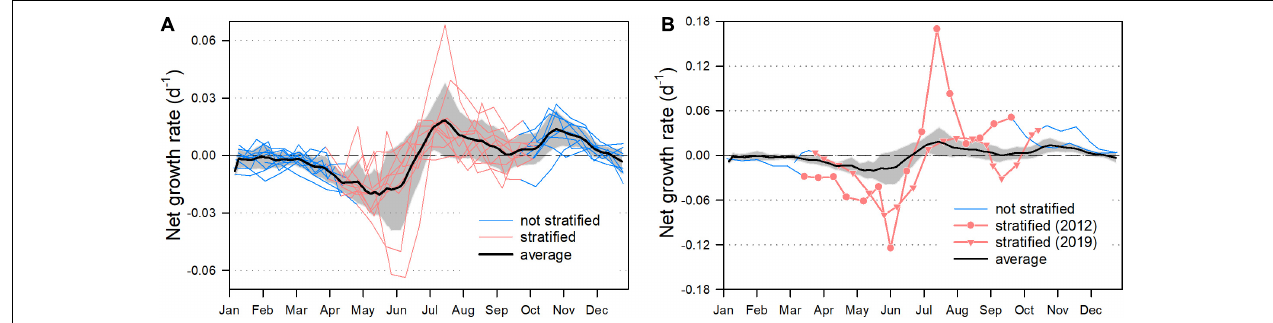
FIGURE 8 | Net growth rate (day – 1 ) of P. rubescens (computations are based on cumulative in vivo chlorophyll a masses presented in Figure 3A ). (A) Net growth rates (day – 1 ) for the entire study period except for the years 2012 and 2019. Each line represents 1 year of investigation: blue coloration indicates that P. rubescens is located in the mixed zone and red coloration indicates the positioning of the cyanobacterium within the stratified metalimnion. Black line: average ± the standard deviation (gray area). (B) Net growth rates for the years 2012 and 2019, with the same color code as in (A) . Black line and gray area: as in (A) for